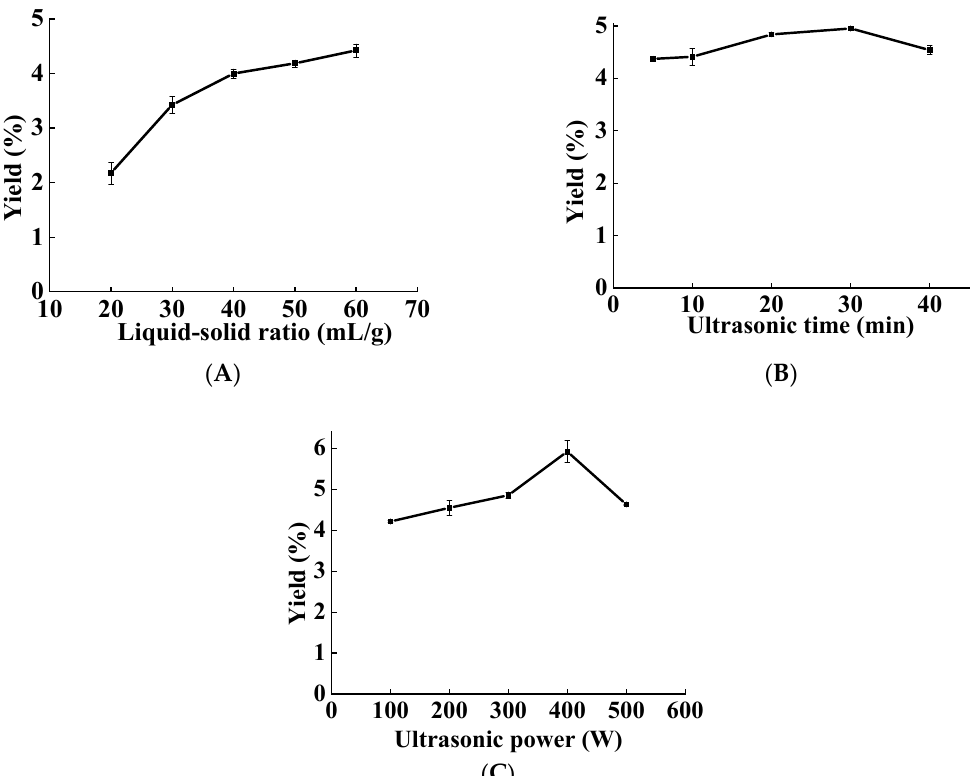
Figure 1. Effect of three factors on the yield of DNP, ( A ) liquid–solid ratio, ( B ) ultrasonic time, and ( C ) ultrasonic power.